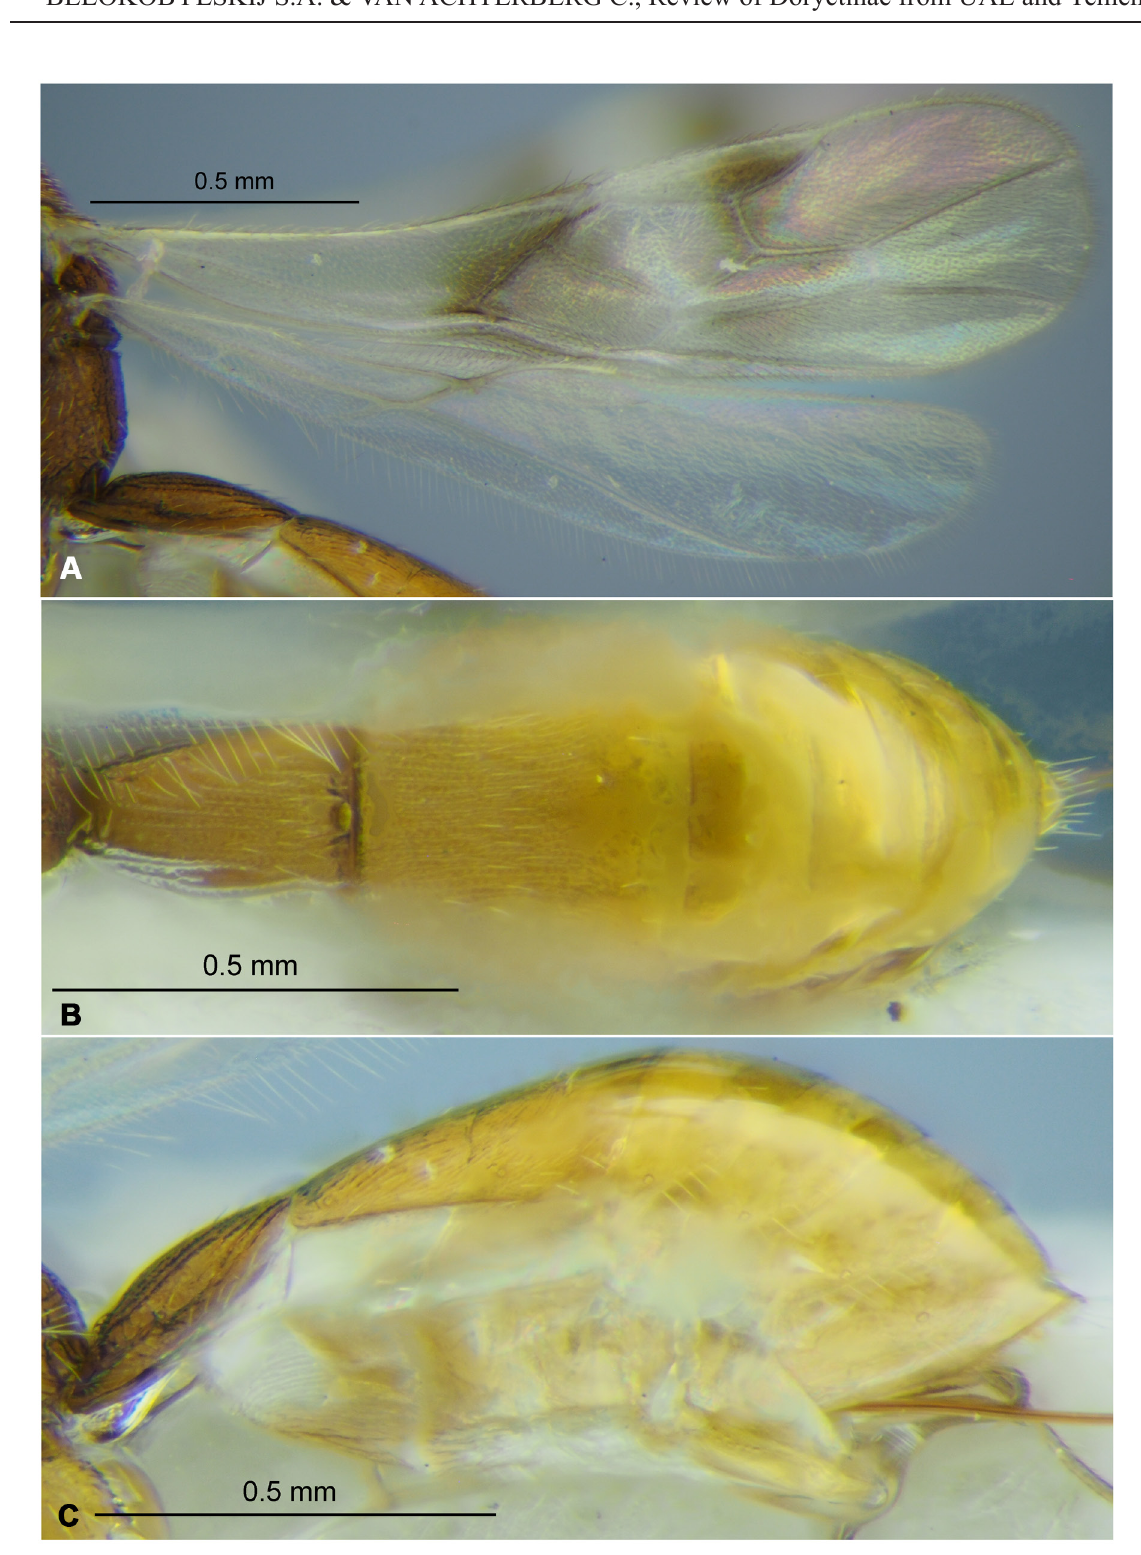
Fig. 4. Dendrosotinus ( Gildoria ) maculipennis Belokobylskij sp. nov., holotype, ♀ (RMNH). A . Wings. B . Metasoma, dorsal view. C . Metasoma, lateral